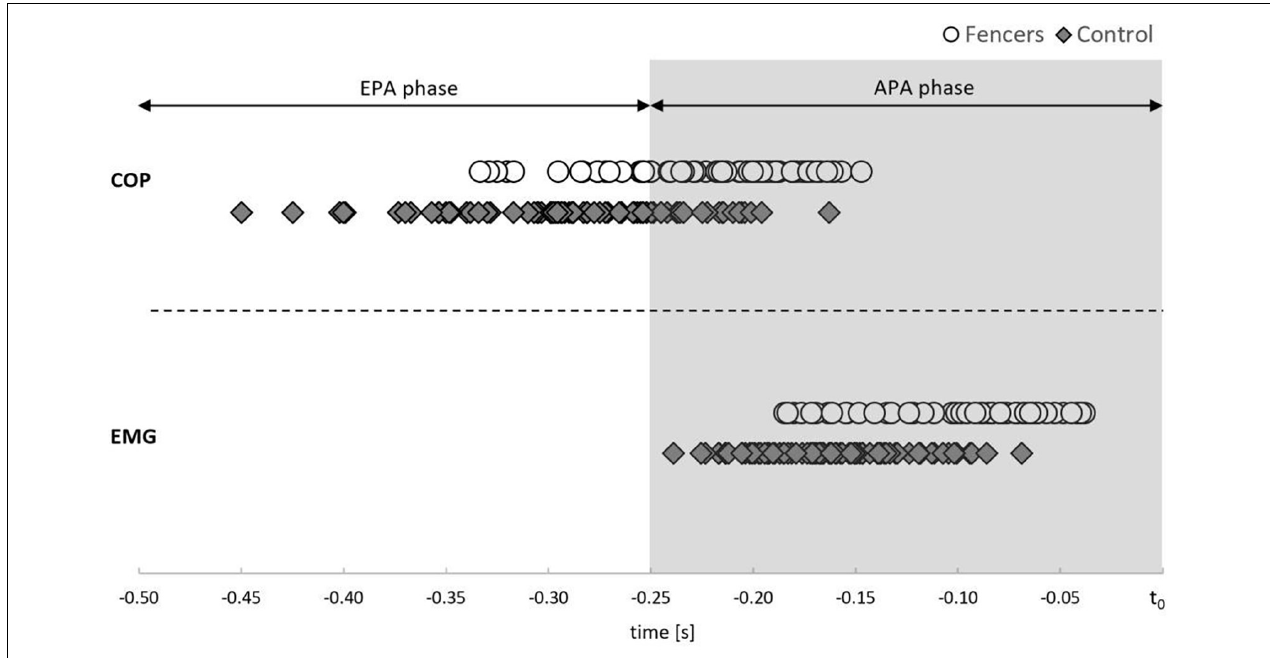
FIGURE 2 | The average time of the onset of COP displacement (above dashed line) and the average time of the onset of TA activity (below the dashed line) in relation to movement onset (t 0 ) for each subject in each experimental condition in fencers and controls. The shaded time interval corresponds to the APA phase, while the white time interval corresponds to the EPA phase.